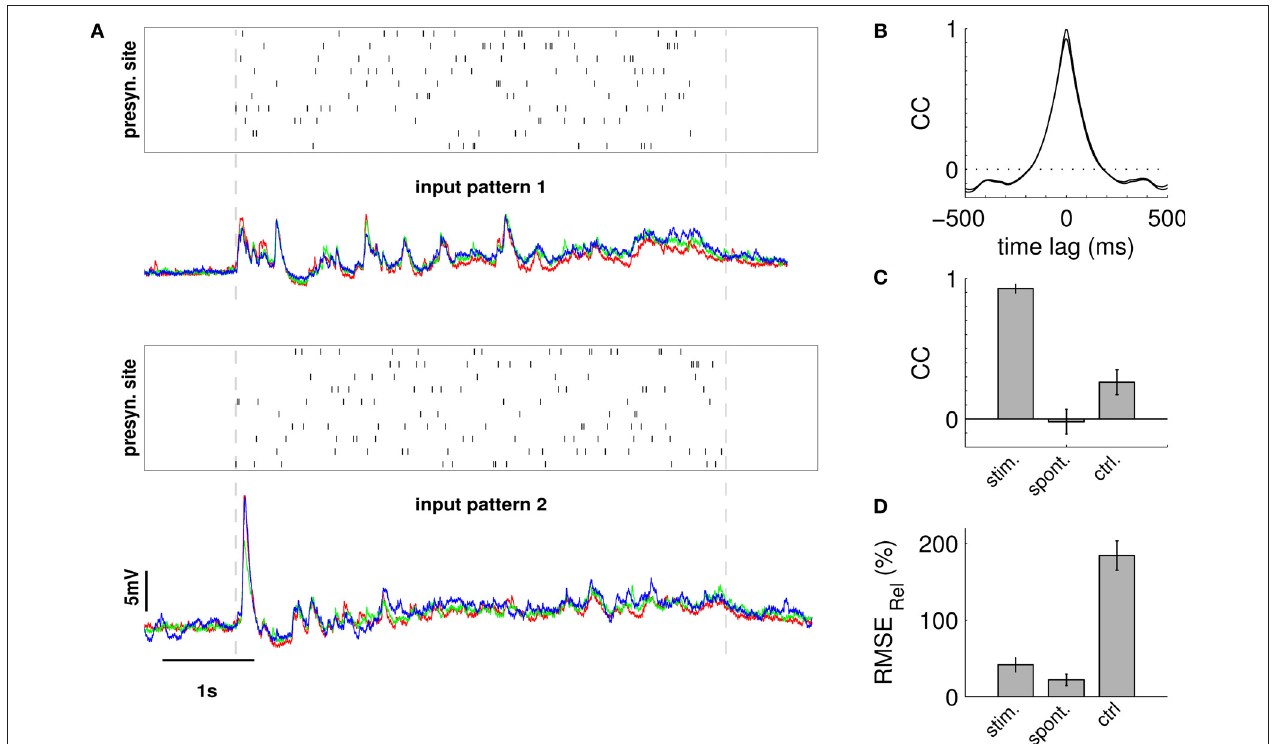
FIGURE 5 | Estimating the infl uence of the experimental system on RMSE and CC measures. The same postsynaptic cell was repeatedly rel stimulated with two distinct spatio-temporal patterns, and, subsequently, RMSE and CC were quantifi ed across trials of the same and across trials of rel different patterns. (A) Raster plots indicate spatio-temporal activation of fi rst (upper) and second (lower) input pattern. The overlay of membrane potential traces below show that each stimulation pattern reliably reproduced the waveform of membrane potential fl uctuation over three consecutive trials, while the voltage traces differed strongly for the different patterns. (B) The average cross-correlation function from pairings of trials of the same stimulation pattern (average over two patterns à three trials) in black is almost identical to the